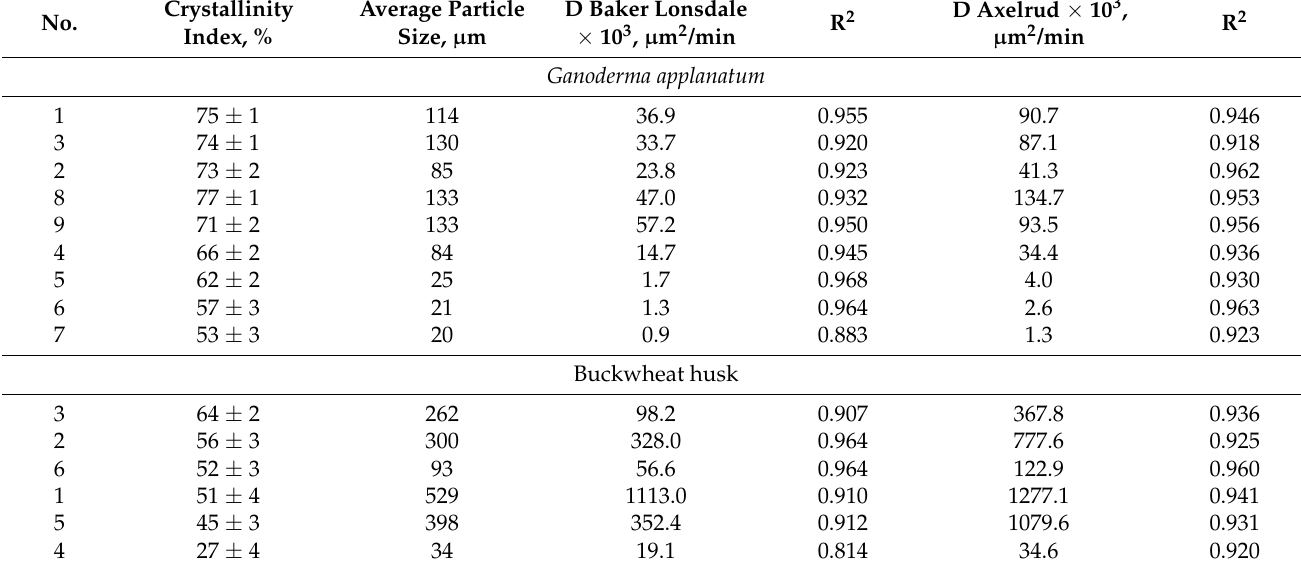
Table 3. The diffusion constants according to the Baker and Lonsdale model as well as the Axelrud model as a function of particle size and crystallinity